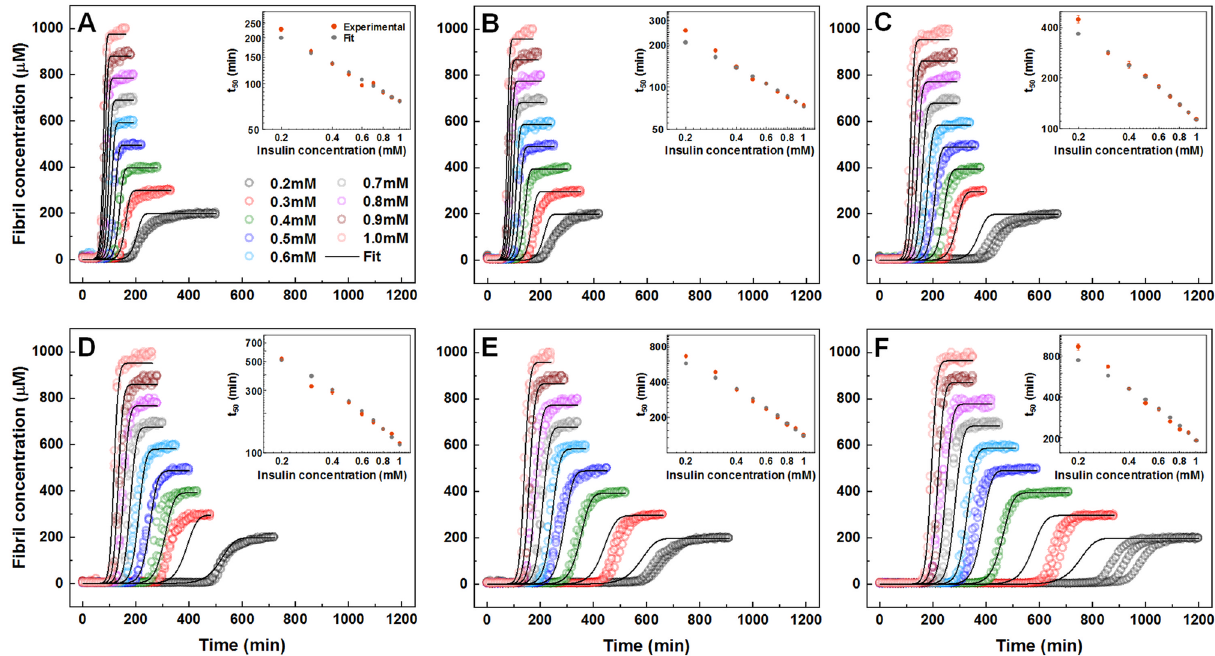
Figure 1. Unseeded aggregation kinetics of insulin without GA ( A ), with 200 µM GA ( B ), 25 µM GAO ( C ), 50 µM GAO ( D ), 100 µM GAO ( E ) and 200 µM GAO ( F ). For each condition, global-fitting was applied using a four-step aggregation model. Inserts show a comparison between t 50 values obtained from both experimental and global-fit